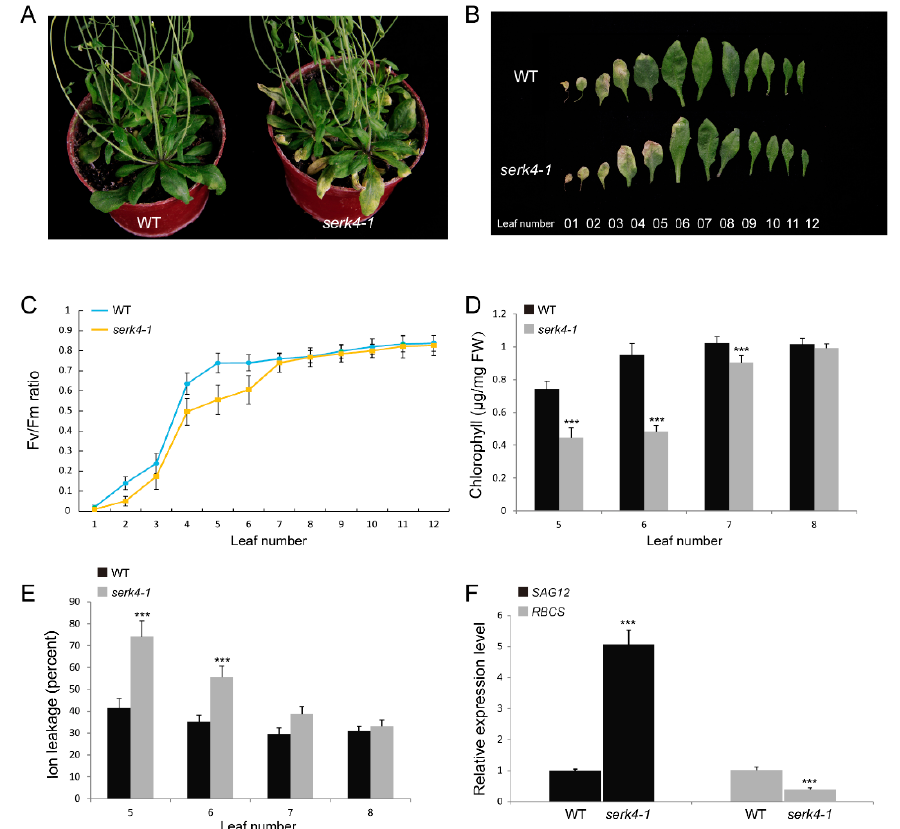
Figure 4. The early senescence phenotype of the serk4-1 mutant; ( A ) the leaf senescence phenotype of the five-week-old serk4-1 mutant and the wild-type plants; ( B ) phenotype of 12 detached rosette leaves from the serk4-1 mutant and the wild type; ( C ) The Fv/Fm of the serk4-1 mutant and the wild type; ( D ) the chlorophyll content of the serk4-1 mutant and the wild type; ( E ) the ion leakage of the serk4-1 mutant and the wild type; ( F ) the expression levels of SAG12 and RBCS in the number 6 rosette leaf of the serk4-1 mutant and the wild type. The ratios of SAG12 and RBCS gene expression level were calculated relative to the wild type, respectively. WT, wildtype. In D, E and F, the data are means ± SD of three biological repeats. *** p < 0.001 ( t -tests).